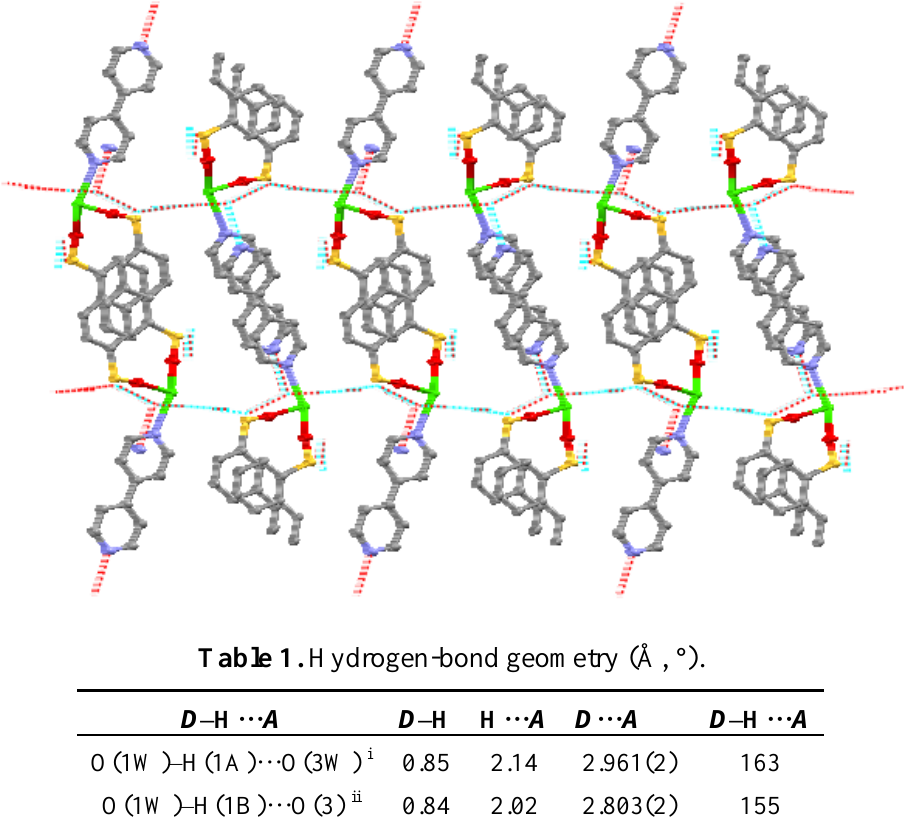
Figure 3. 3D network structure of the Ca(II) coordination polymer.